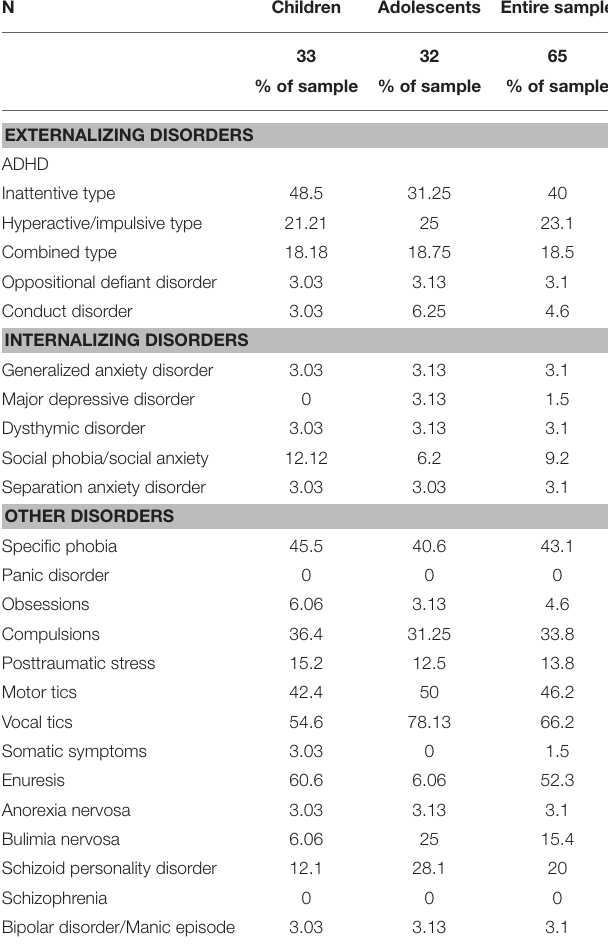
TABLE 2 | Prevalence of participants meeting clinical cut-off scores on CASI-5 symptom